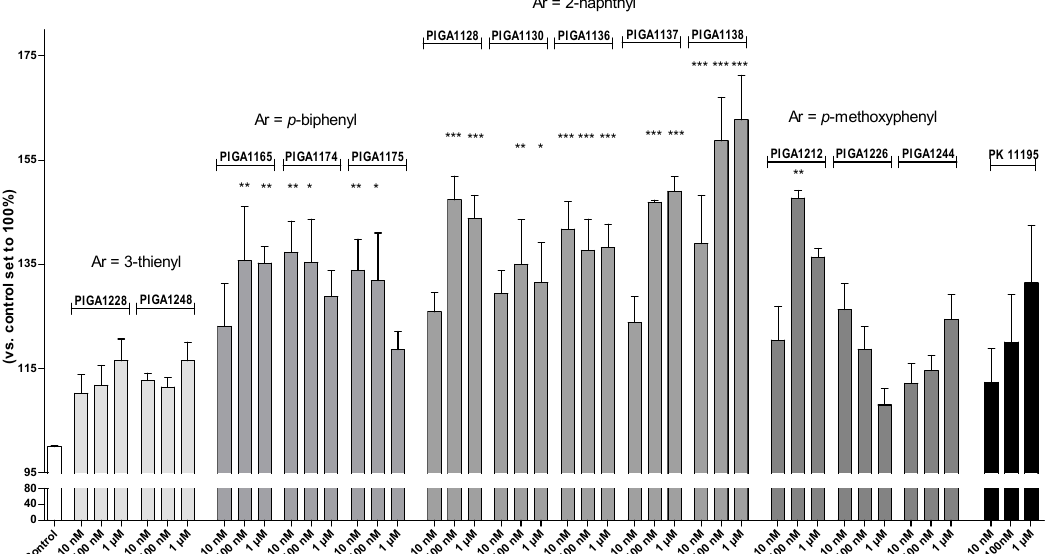
Figure 1. Effects of the PIGA ligands on the Oxidative Metabolism Activity/Proliferation index in U87MG human glioma cells. U87MG cells were treated with different concentrations of the compounds (10 nM–1 µM) in serum-reduced media (1% fetal bovine serum (FBS)), and the [3-(4,5-dimethylthiazol-2-yl)-5-(3-carboxymethoxyphenol)-2-(4-sulfophenyl)-2 H -tetrazolium, inner salt] (MTS) assay was performed after 48 h of treatment. The data are expressed as percentages of the proliferative/oxidative metabolism activity index compared to the control (0.1% dimethyl sulfoxide (DMSO), a concentration that not interfered with the assay), which was set to 100%, and represent the means ± standard error of the mean (SEM) of three different experiments performed in duplicate. The statistical analysis was performed using one-way analysis of variance (ANOVA) and Bonferroni’s post-test; * p < 0.05, ** p < 0.01, *** p < 0.001 vs. the control.